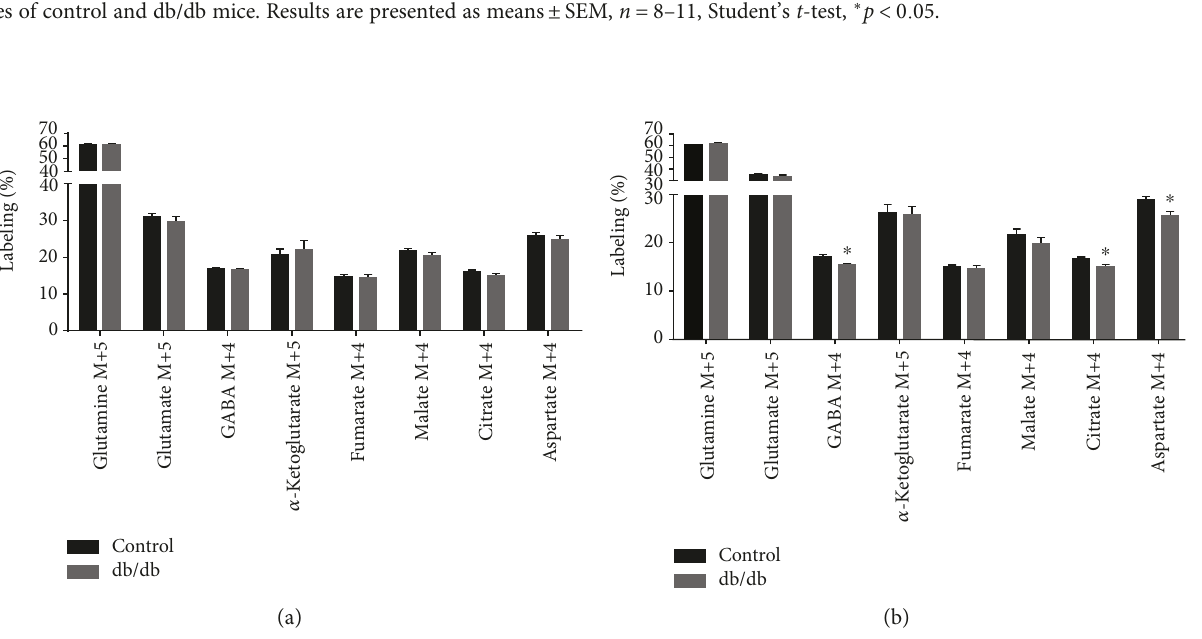
Figure 5: 13 C labeling from [U- 13 C]glutamine metabolism of cerebral cortical and hippocampal slices of control and db/db mice. TCA cycle intermediates and amino acids labeled from [U- 13 C]glutamine metabolism during incubations of cerebral cortical (a) and hippocampal (b) slices of control and db/db mice. Results are presented as means ± SEM, n = 11 , Student ’ s t -test, ∗ p < 0 05 Supplementary Figure 1 available online at https://doi.org/ 10.1155/2017/2107084).